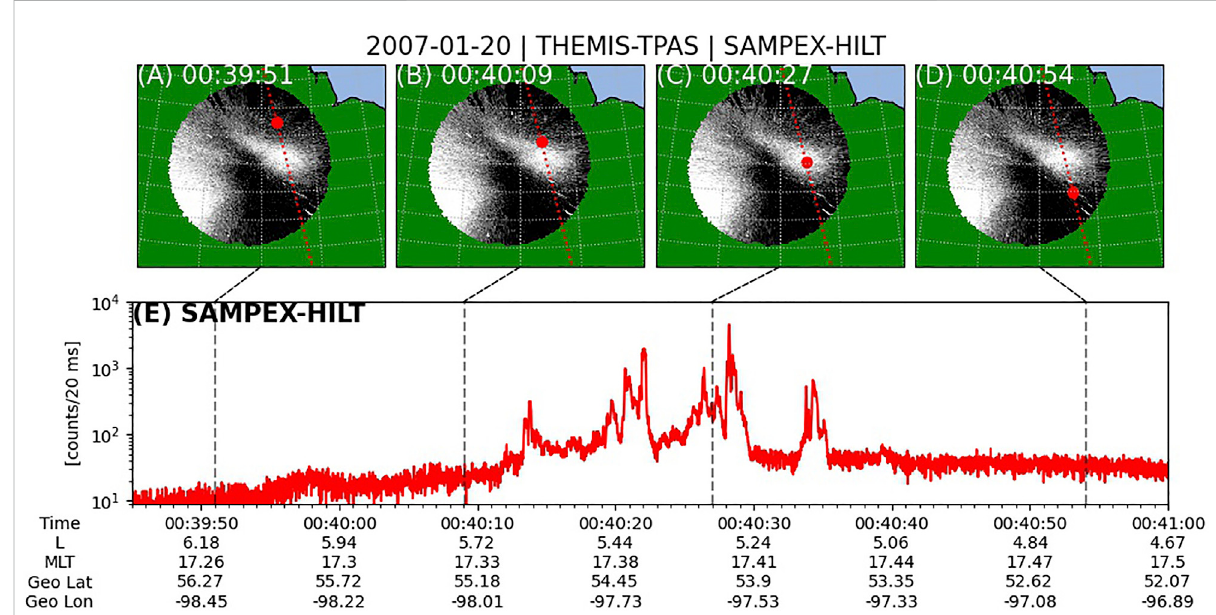
FIGURE 3 Select ASI images, and relativistic electron microbursts observed during the conjunction. (A – D) show select THEMIS ASI images from The Pas mapped to 110 km altitude. The SAMPEX footprint and its instantaneous position are shown by the dotted red line and the large red circle. The intensity bounds are identical between the images. (E) shows the SAMPEX-HILT time series with vertical guides at times that correspond to the ASI images in (A – D) . The minor ticks are at every second. The HILT instrument observed microbursts only when it passed above the proton